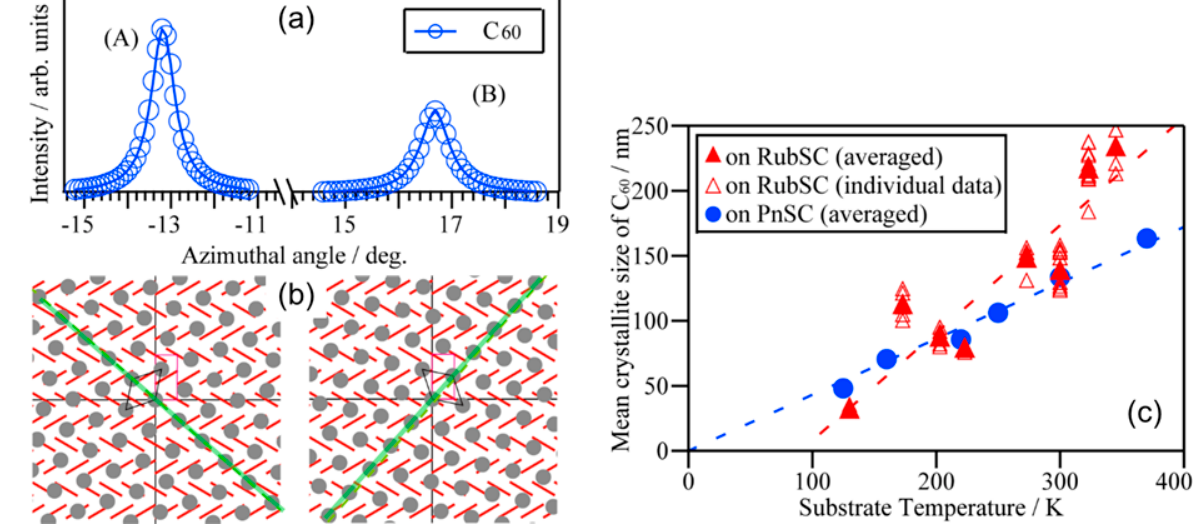
Figure 11. ( a ) Precise ϕ profiles of C 60 22(cid:3364)0 spots of the domains (A) and (B) taken by HR-GIXD. ( b ) Schematic diagrams representing inter-lattice relationships for the domain (A) and (B) of the epitaxial C 60 on the RubSC ( 100 ) surface. The surface unit cells of C 60 and RubSC are indicated by black- and red-colored lines, respectively, and the [ 02(cid:3364)1 ] and [ 021 ] directions of RubSC for the (A) and (B) domains, respectively, are shown with green lines. ( c ) In-plane mean crystallite size of C 60 on RubSC depending on the growth temperature derived from the HR-GIXD spot profiles of the C 60 22(cid:3364)0 spots. The temperature dependence for the C 60 on PnSC case (same as the data shown in Figure 7b) is also displayed for reference. Cited from [40].